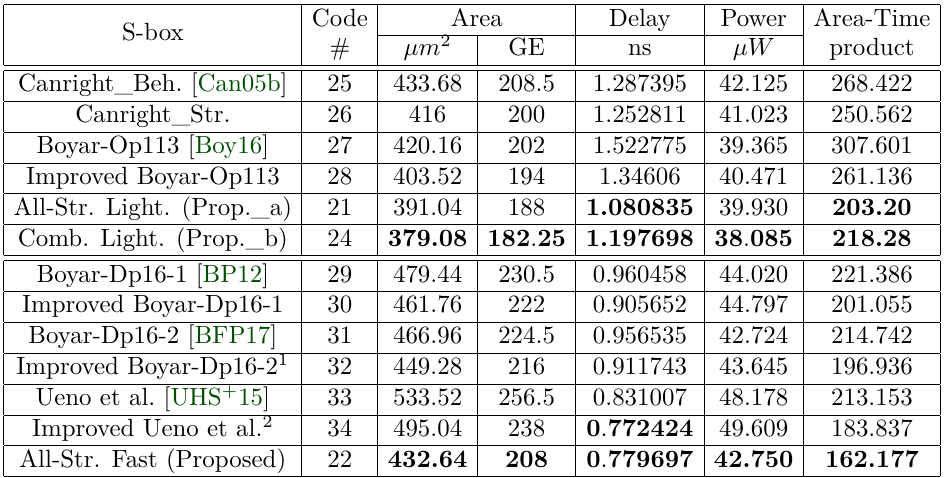
Table 12: ASIC comparisons of the S-box